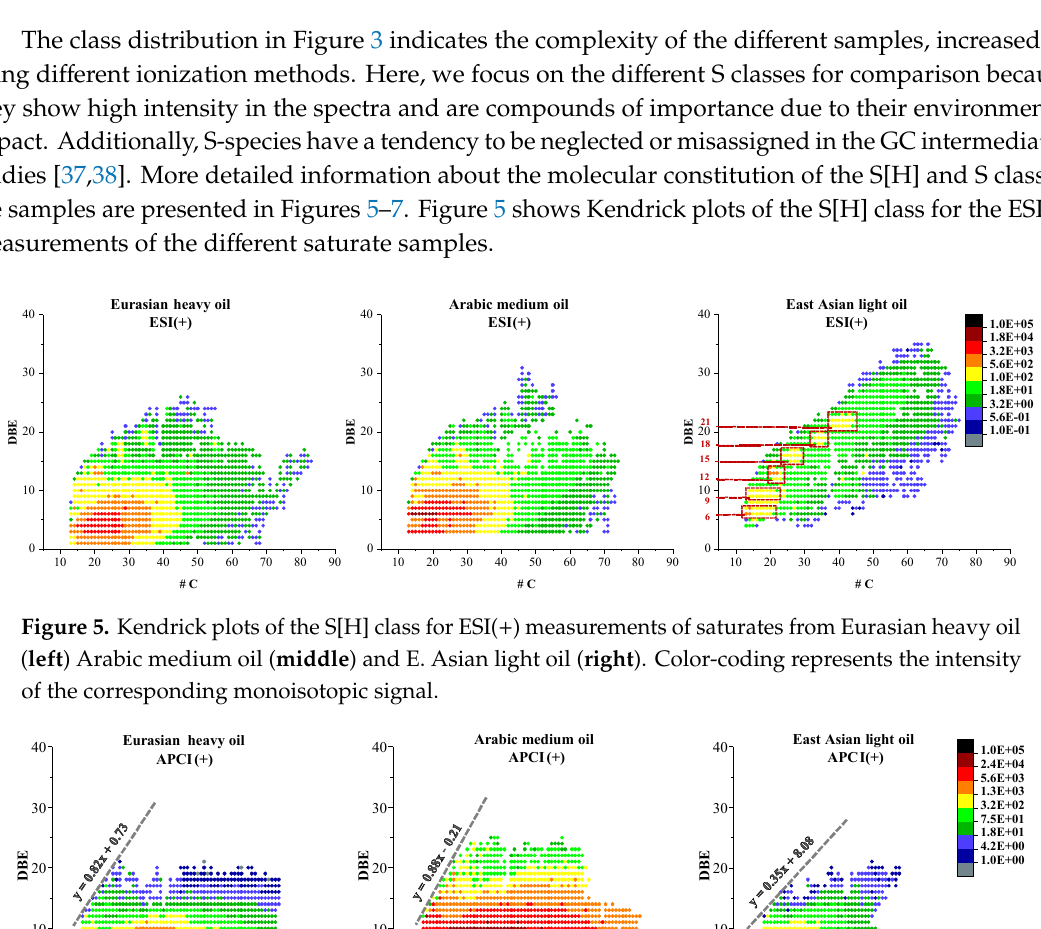
DBE value. Color-coding represents the intensity of the corresponding monoisotopic